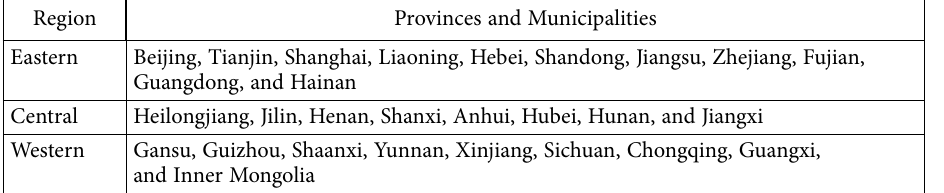
Table 2. Areas in